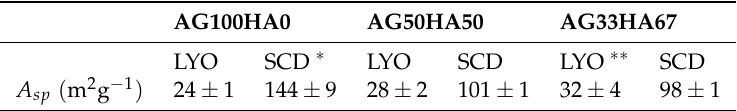
Table 1. Specific surface area measured by BET of lyophilized (LYO) and supercritically-dried (SCD) samples. ∗ : significant difference at the 95% level ( p < 5 × 10 − 6 ) against both composites, ∗∗ : significant difference at the 95% level ( p = 0.00161) against pure